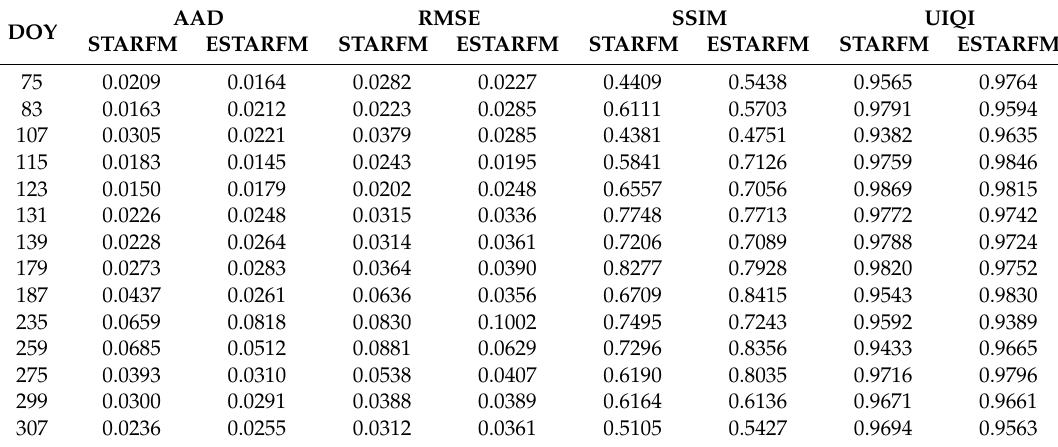
Figure 9. The e ff ect of cloud, cloud shadow, or ice to one of NDVI in 2000, which was interpolated by the Savitzky–Golay (S–G) filter. Table 4. Accuracy comparison of STARFM and ESTARFM, where AAD, RMSE, SSIM, and UIQI represent the average absolute di ff erence (AAD), the root mean square error (RMSE), the structural similarity (SSIM), and the universal image quality index